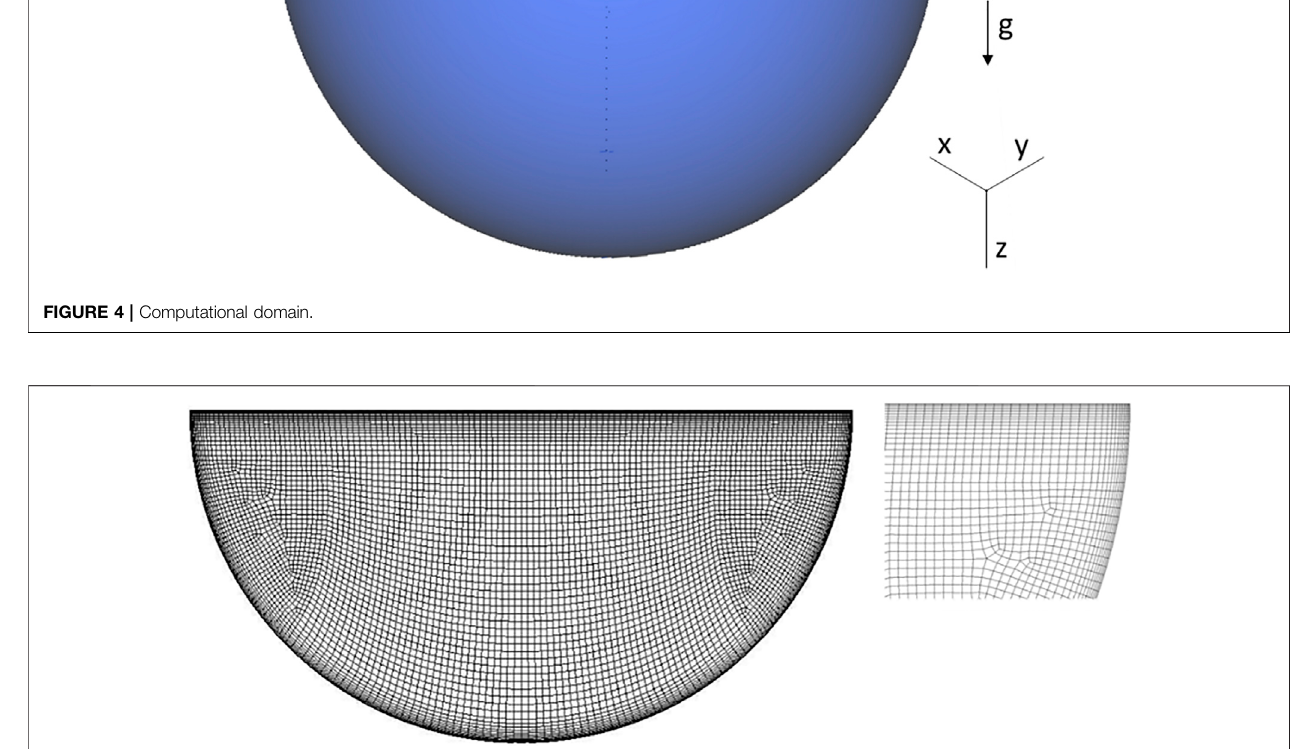
FIGURE 5 | Mesh on a middle slice of the computational